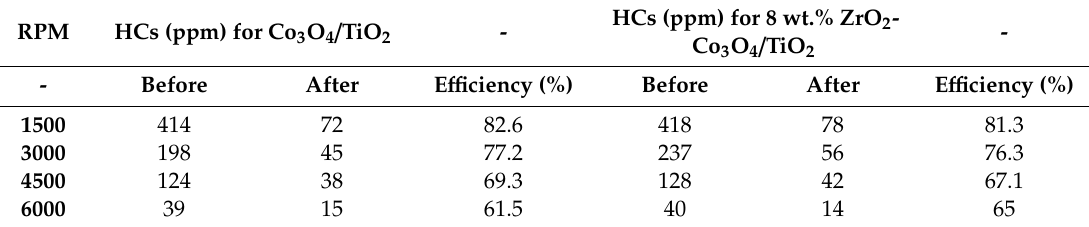
Table 3. Real time conversion results of HCs with both